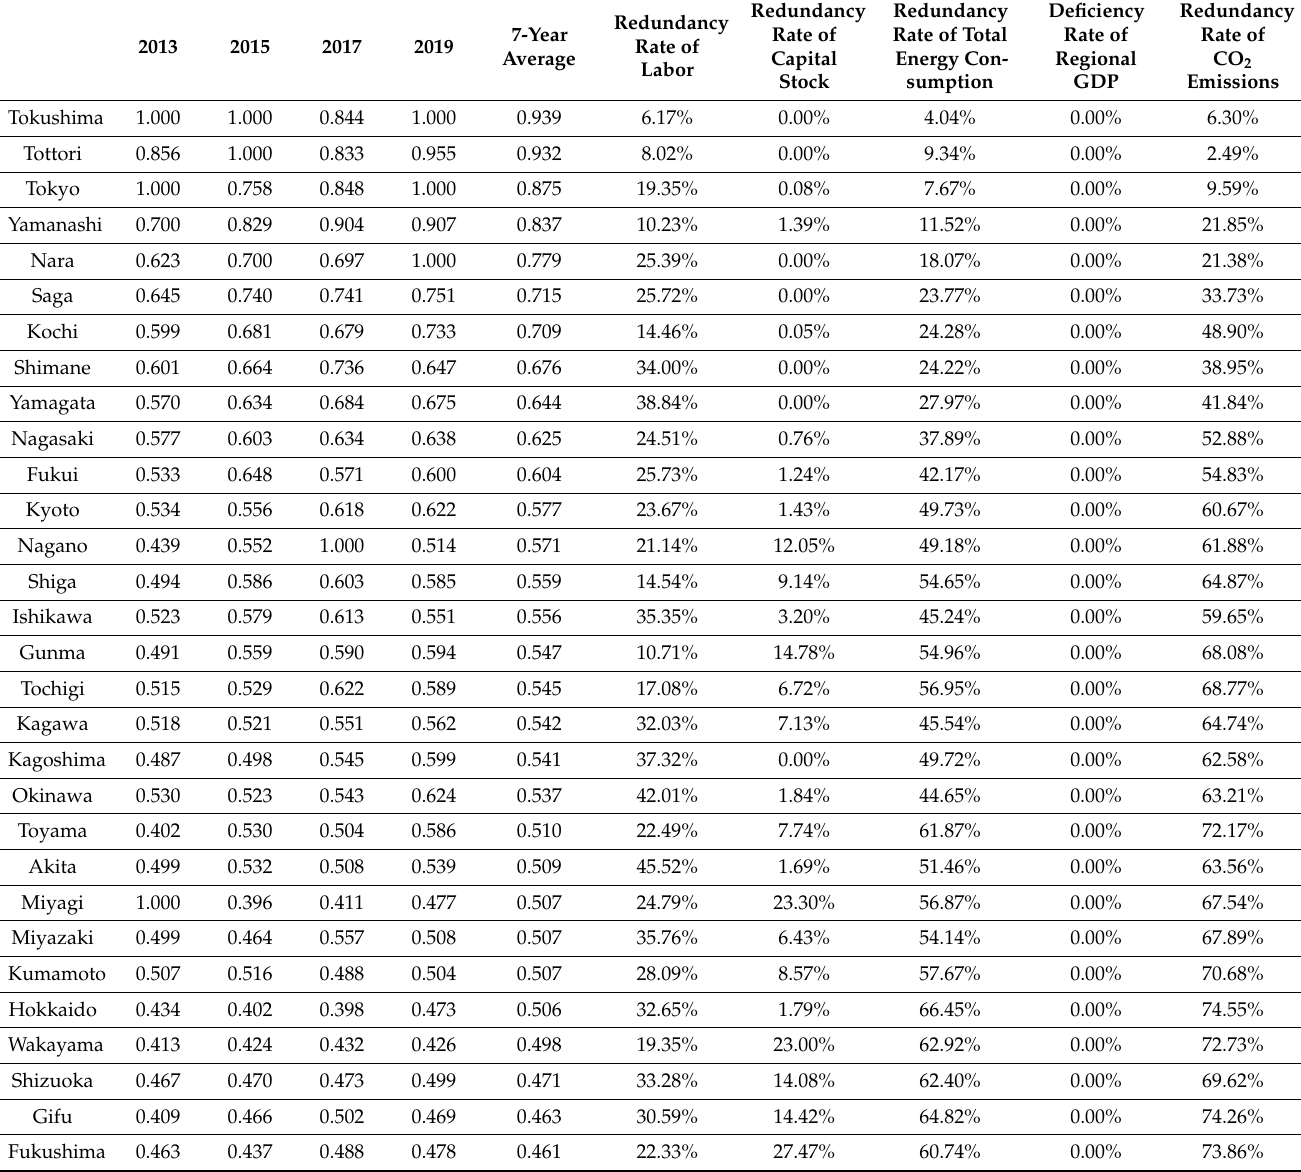
Table 6. Evaluation results of low carbon economic efficiency value in Japan from 2013 to